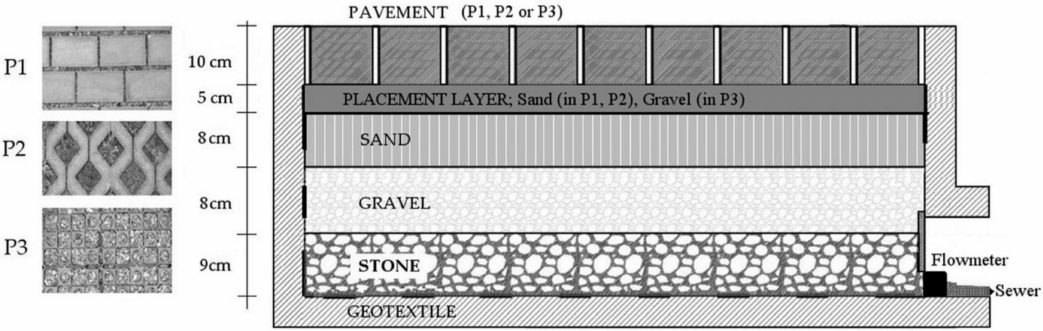
Figure 1. Profile of sub-base used for test areas.